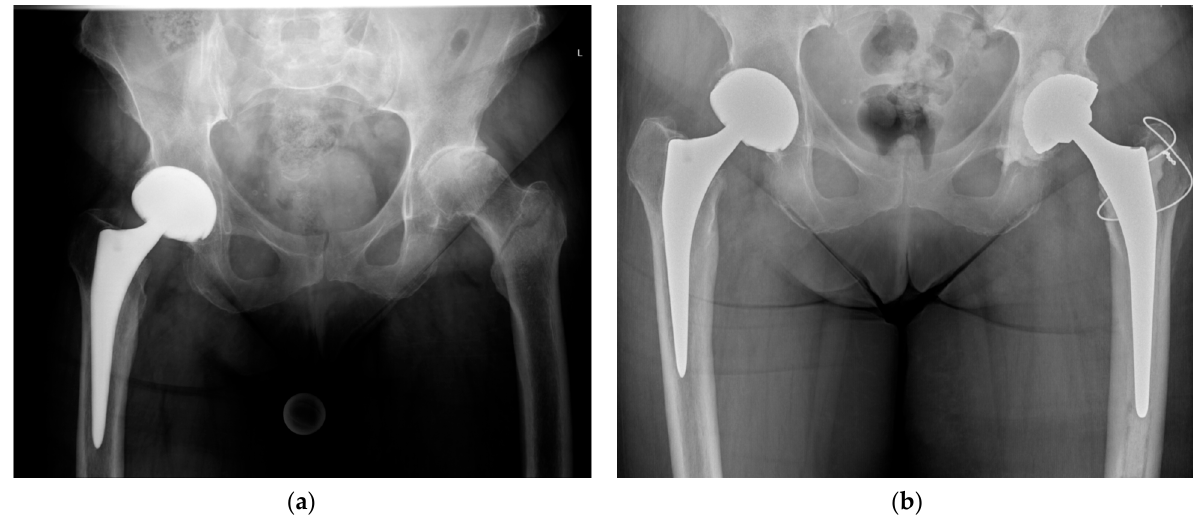
Figure 2. ( a ) Preoperative anteroposterior pelvic radiograph of an intertrochanteric femur fracture with concomitant osteoarthritis of the left hip; ( b ) postoperative anteroposterior pelvic radiograph after total hip arthroplasty with a cemented femoral stem, fixation of the greater trochanter by a figure-of-eight wire cerclage, and a cemented acetabular cup.